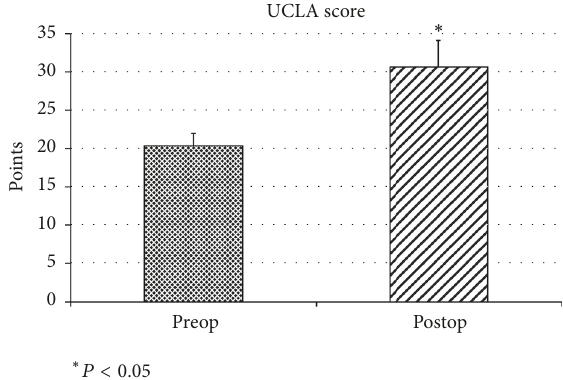
Figure 4: UCLA score . At the last follow-up, the UCLA score improved from the preoperative mean of 20.4 points to 30.6 points. There was significant difference between preoperative and last follow-up score in the JOA score ( 𝑃 < 0.01